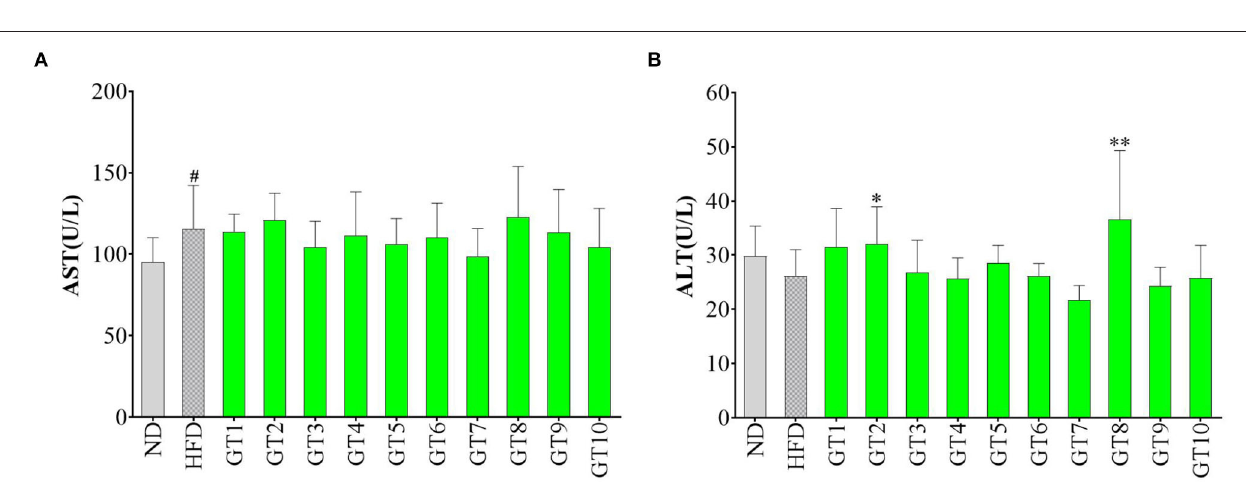
Frontiers in Nutrition |